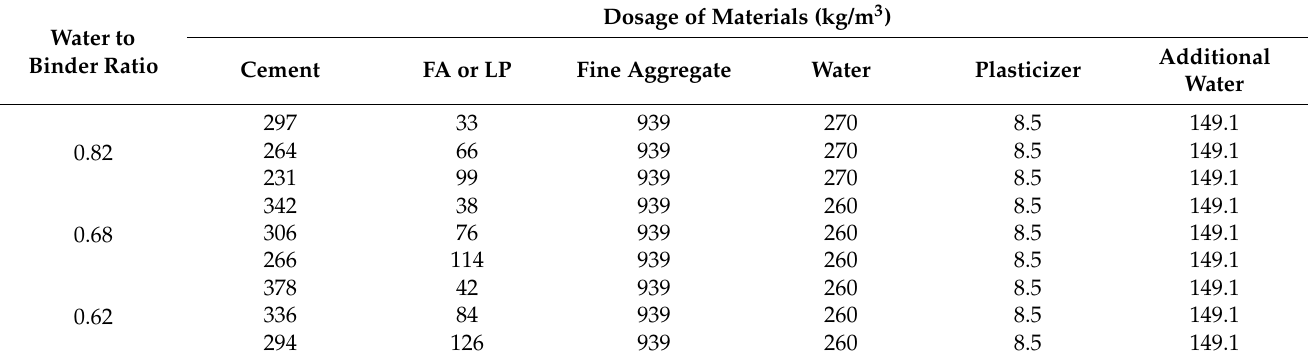
Table 5. Mix proportions of the mortars with fine-aggregate sintered